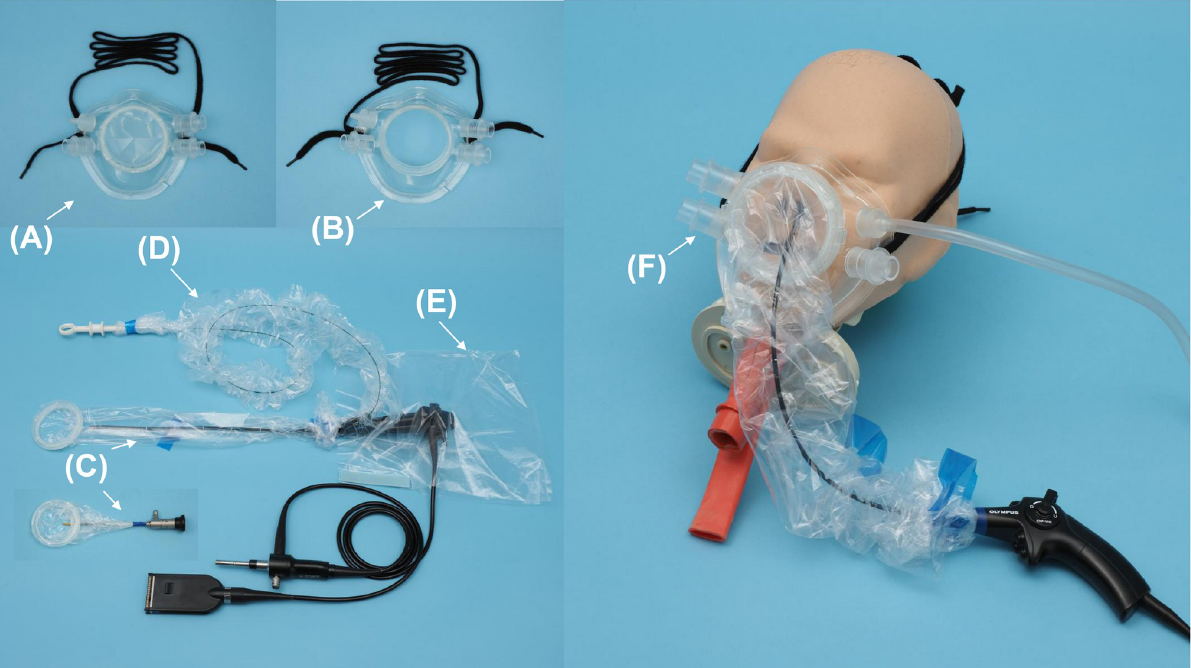
Fig 1. Images of the prototype product. (A) A mask with a rubber slit (for outpatient use). (B) A mask without a rubber slit (for surgery). (C) Insertion sleeve (attached to a flexible endoscope [Olympus ENF-VT3; Olympus Medical Systems Corporation, Tokyo, Japan] and a rigid